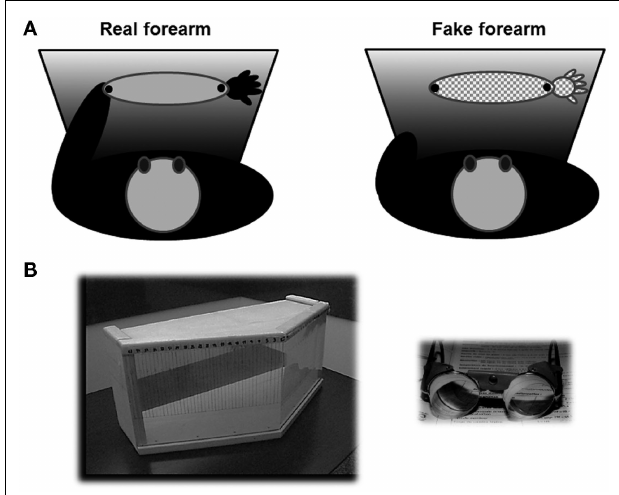
FIGURE 2 | (A) Schematic bird’s eye view of the experimental setting for the real (left, light gray) and fake (right, pattern) forearm. Participants wore a black mantle, and they could see only their real forearm, which lay outside of two side holes of the mantle, or the fake forearm; black dots limited the extent of the real/fake forearm considered for the bisection task. (B) On the left, the box used for prism adaptation by repeated pointing trials, closed by the removable plexiglas, seen from the examiner’s side (Fortis et al., 2010). Marks for the recording of the patients’ pointing errors are shown. On the right, the prismatic goggles inducing a 10˚ shift of the visual field to the